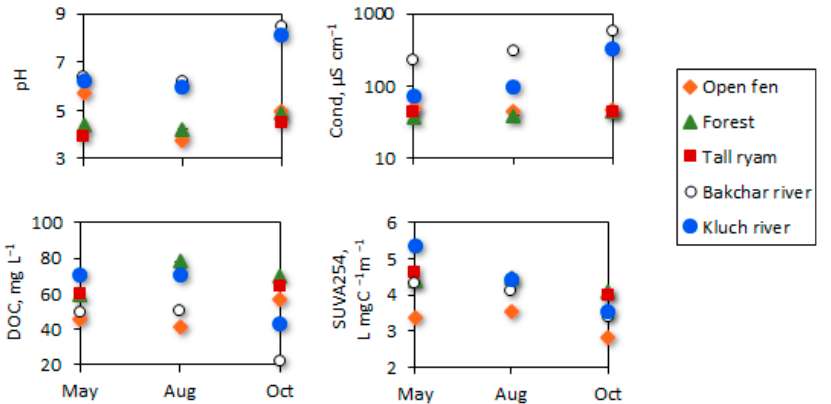
Figure 3. Some initial water parameters in different mire micro-landscapes and rivers by season.